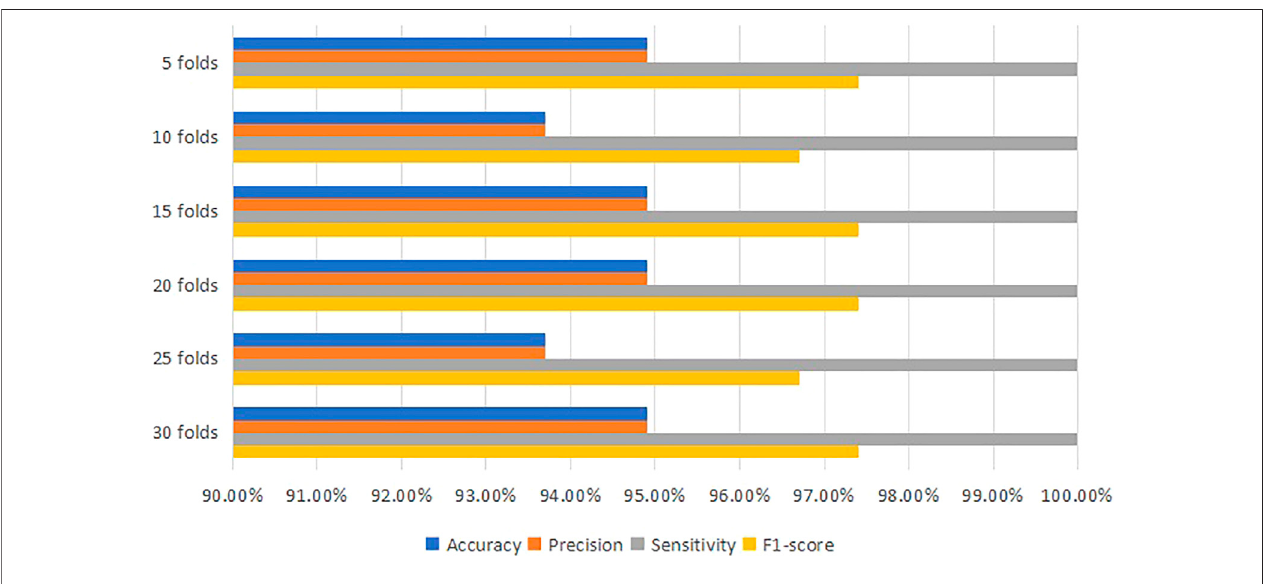
FIGURE 4 | Comparison diagram for the performance of SVM classi fi er.